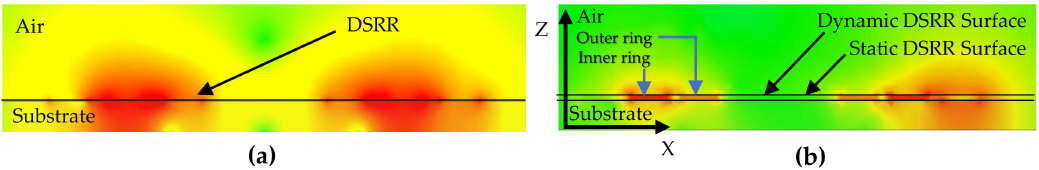
Figure 5. Electric field distribution of ( a ) single- and ( b ) stacked-DSRR in a similar ZX cross-section.